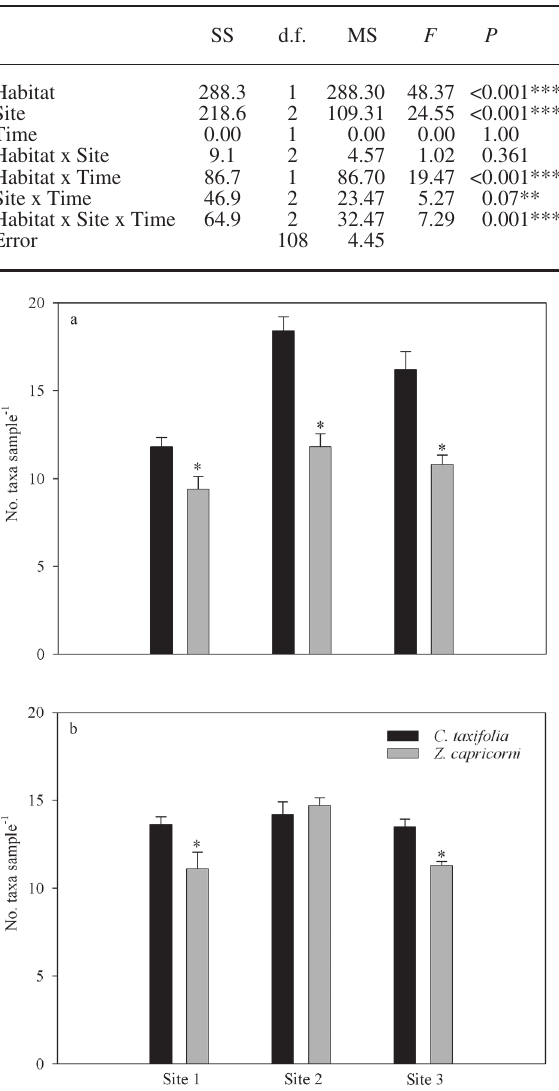
(presence-absence data) displayed two different groupings: one formed by samples from Sites 2 and 3 at the Towra Point Nature Reserve and another formed by samples from Site 1 at Kurnell Penin- sula. Further subgroups were caused by differences between samples of Caulerpa taxifolia and Zostera